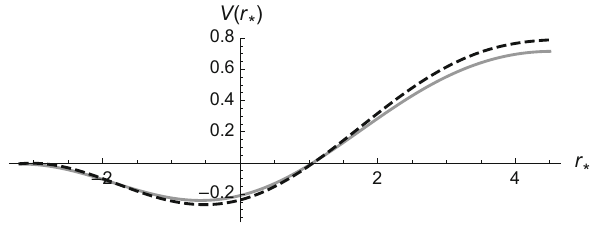
Fig. 1 Plot of the Zerilli potential, as a function of the brane tension: the grey line refers to the GR σ → ∞ limit, whereas the black dashed line represents the current large value for the brane tension bound σ ∼ 3 . 184 × 10 6 MeV